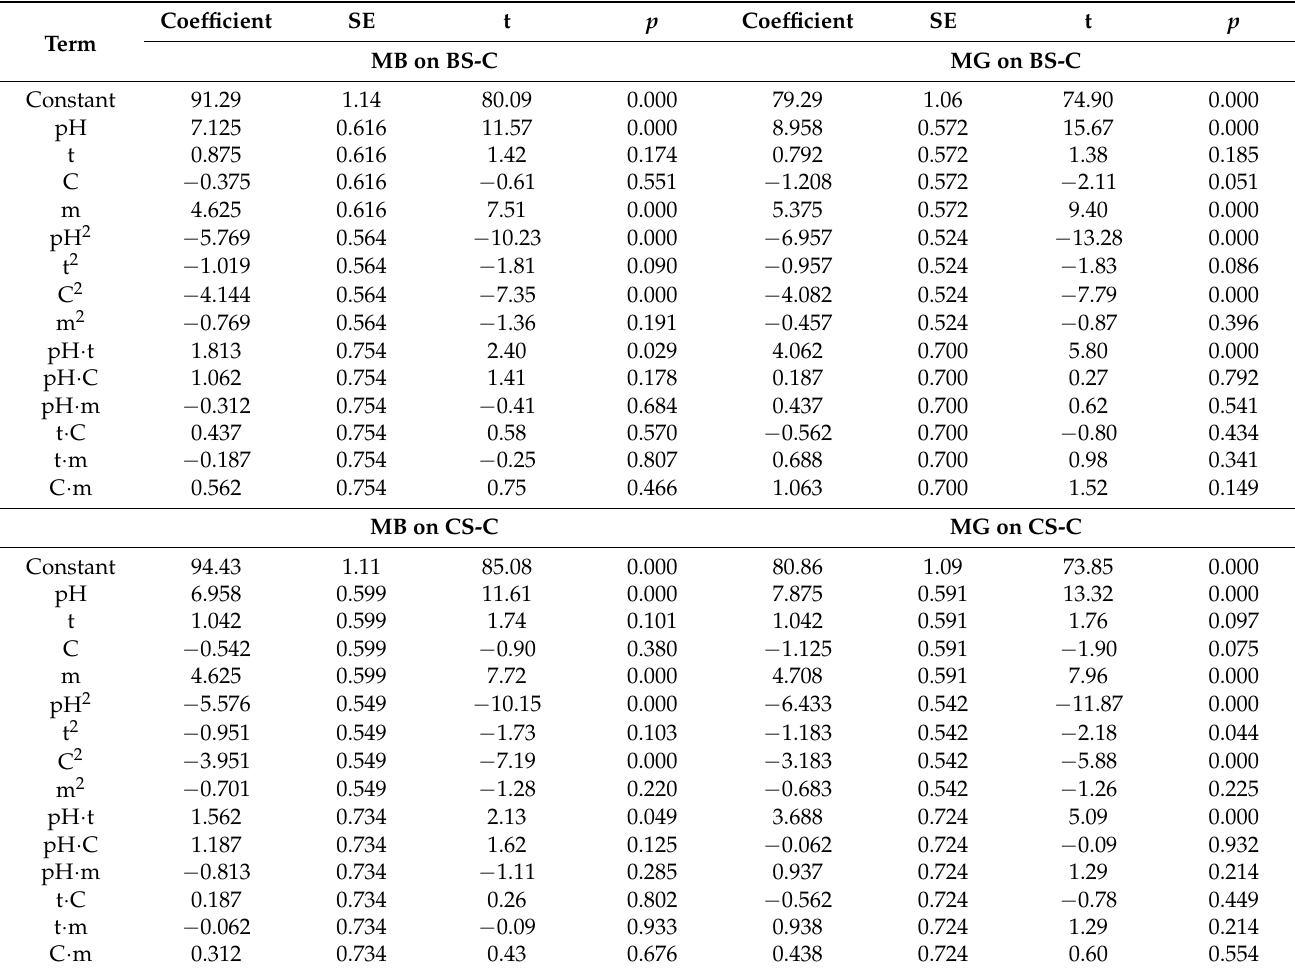
Table 5. Estimated regression